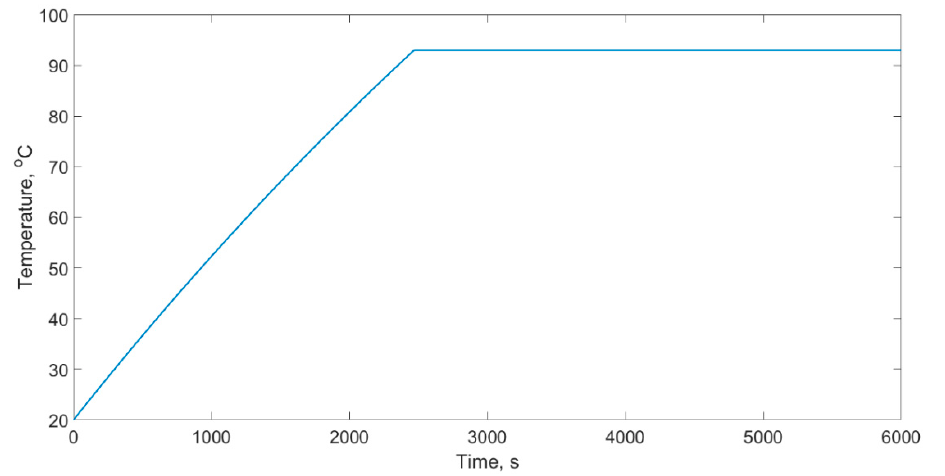
Figure 3. Step response of the control object.